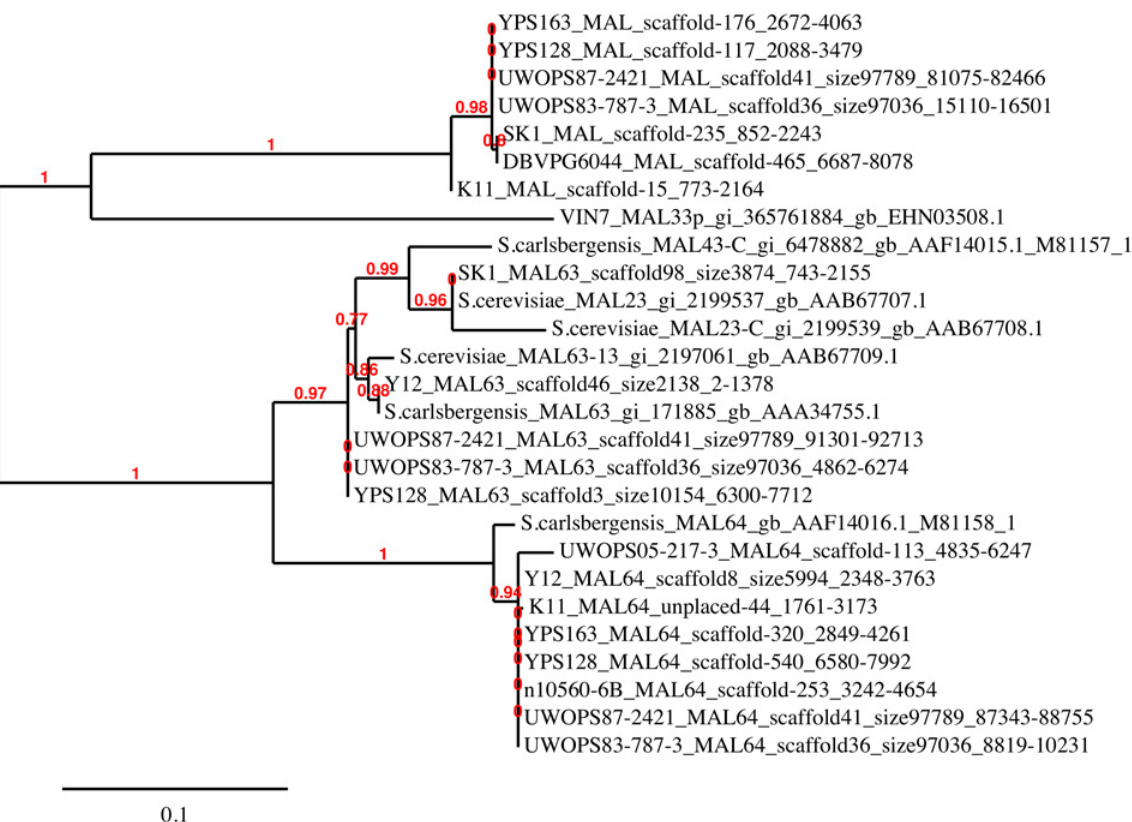
Fig 6. Phylogenetic tree of the non-reference MAL gene family. The MAL23 , MAL43 , MAL63 , and MAL64 genes are known non-reference features that may be associated with maltose activator function. We included all non-reference MAL activator genes identified in S . cerevisiae including sequences from this study, sequences from Bergstrom et al . [17], and ones deposited in the NCBI protein database. The MAL genes have been found in environmental and saké strains, but have not been detected in baking and European wine strains. One group of MAL genes in the upper part of the gene tree, detected in K11, YPS128, YPS163, UWOPS87, UWOPS83, SK1, and DBVPG6044 strains, is clustered separately from the other MAL